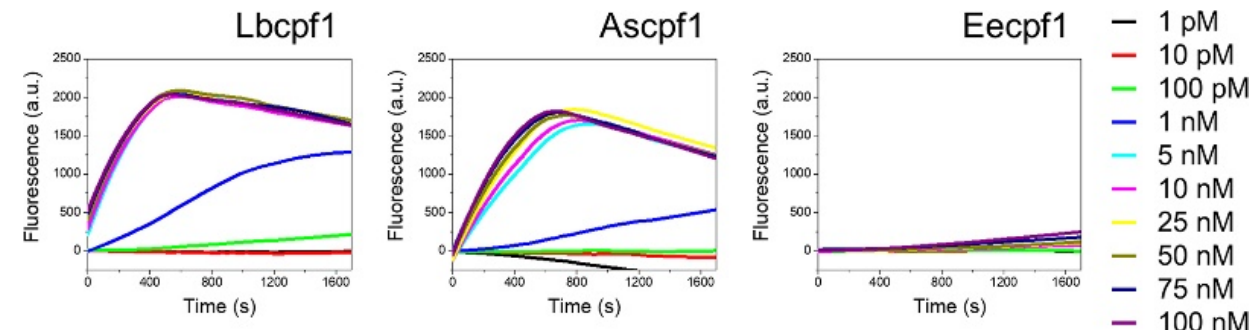
Figure 2. Collateral activity of Lbcpf1, Ascpf1, and Eecpf1 using varied concentrations of T1. Eecpf1 activity is measured in the presence of 1 mM MnCl 2 compared to Lbcpf1 and Ascpf1 activities in MgCl 2 .